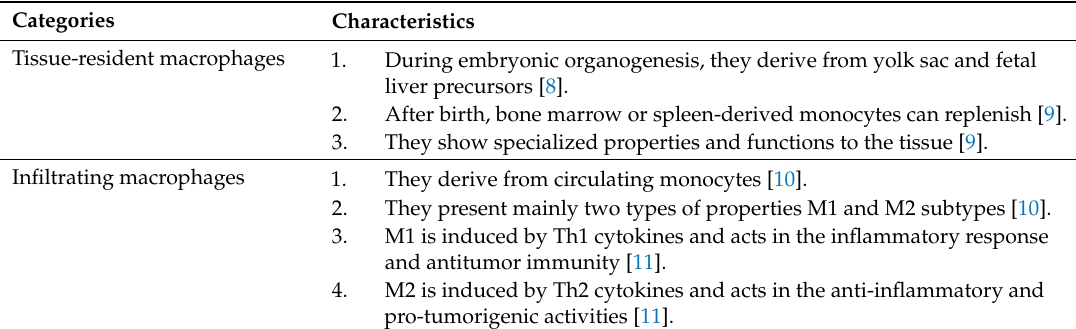
Table 1. The categories and characteristics of